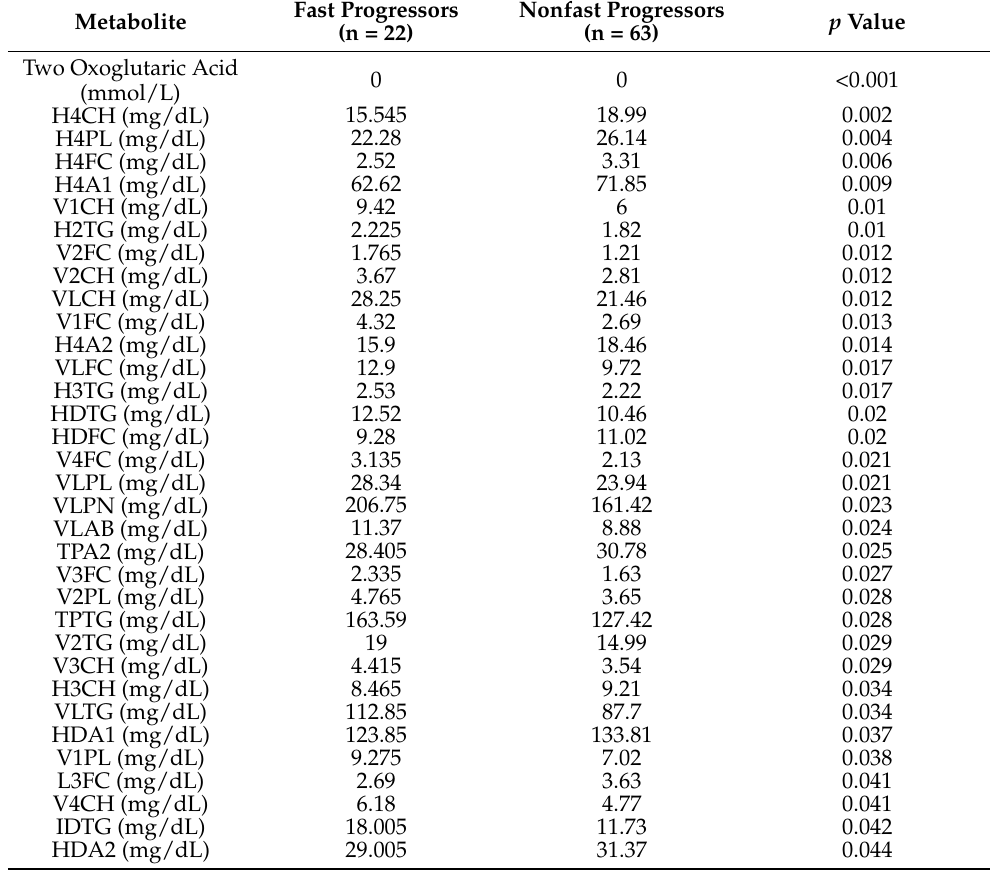
Table 4. Differences in metabolic profile between fast progressors and nonfast progressors in patients who had a liver